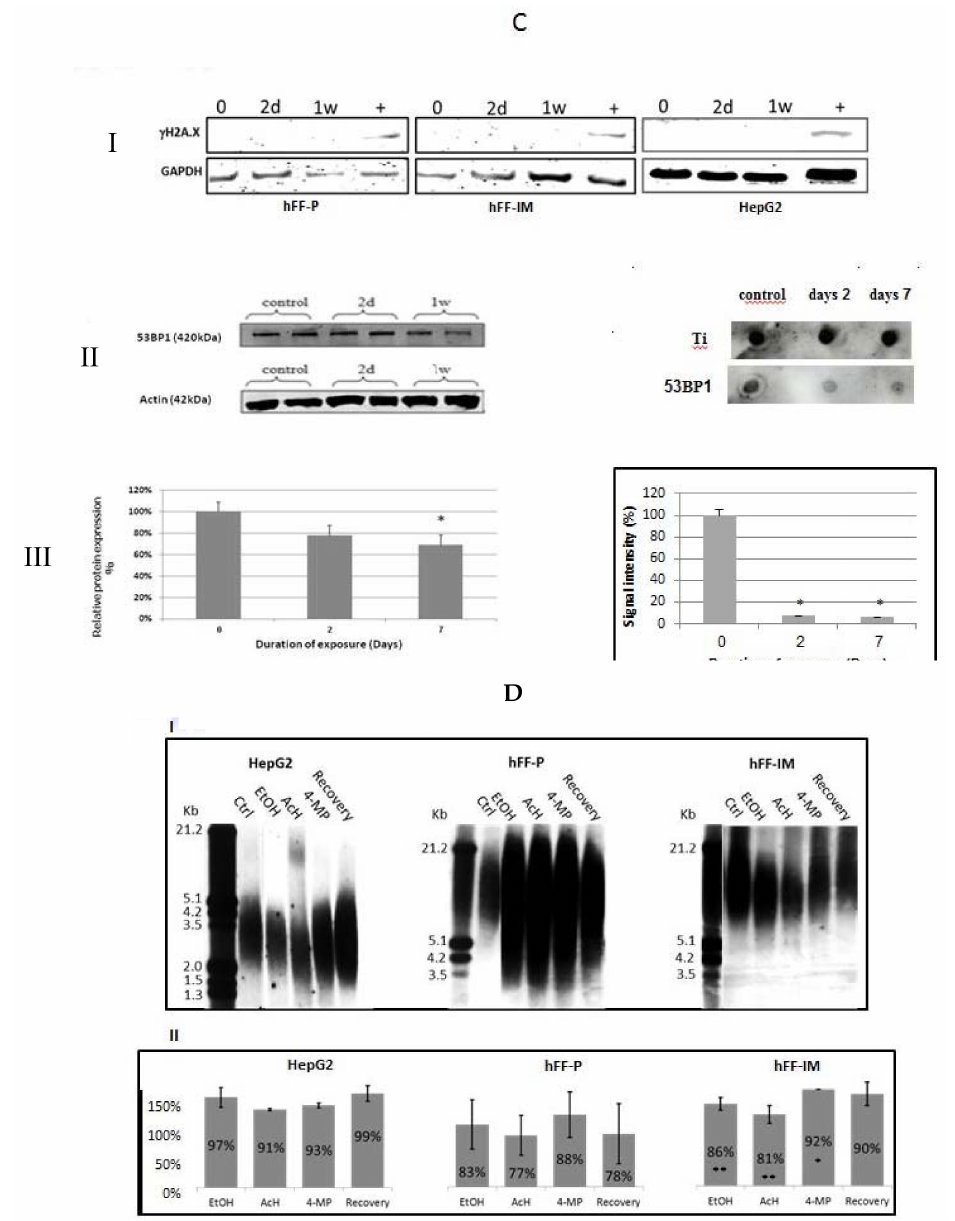
Figure 4. Viability of Primary hFF cells after knockdown of XPF. ( A ) XPF expression was knocked down by stable transfection with a specific shRNA plasmid. (I) an example of one transfected clone; (II) a control sample transfected clone with shRNA against GFP; (III) a control sample transfected clone with a scrambled shRNA (IV) a control intact sample. ( B ) (I) Telomere length in Primary hFF cells treated with PARP1 inhibitors as measured by Southern blotting. Cells were treated with EtOH (E) and both PARP1 inhibitors for seven days (3AB–2 mM 3-Aminobenzamide, IQD- 0.1 mM 1,5-Isoquinolinediol). C: Control cells. C + E: cells treated with 25 mM ethanol as above. IQD + E: cells treated with 1,5-Isoquinolinediol and 25 mM ethanol. Each lane contains a smear that represents the varied length of the TLs in the specific sample. (II) Quantitation of Southern blot experiments showing the mean TRF values of treated vs. untreated cells calculated as percentage of control. * p < 0.001. ( C ) γ H2AX and 53bp1 expression in all cells after treatment with 25 mM EtOH for two days and one week. Cells were exposed to 25 mM EtOH for two days or one week and the levels of γ H2AX and 53bp1 were measured by Western